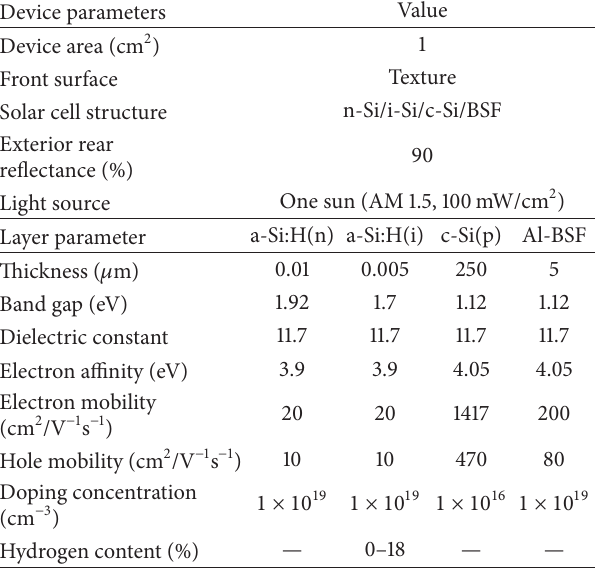
Table 1: TCAD input parameters for n-Si/i-Si/c-Si HJ solar cells with various hydrogen content of i-layer.